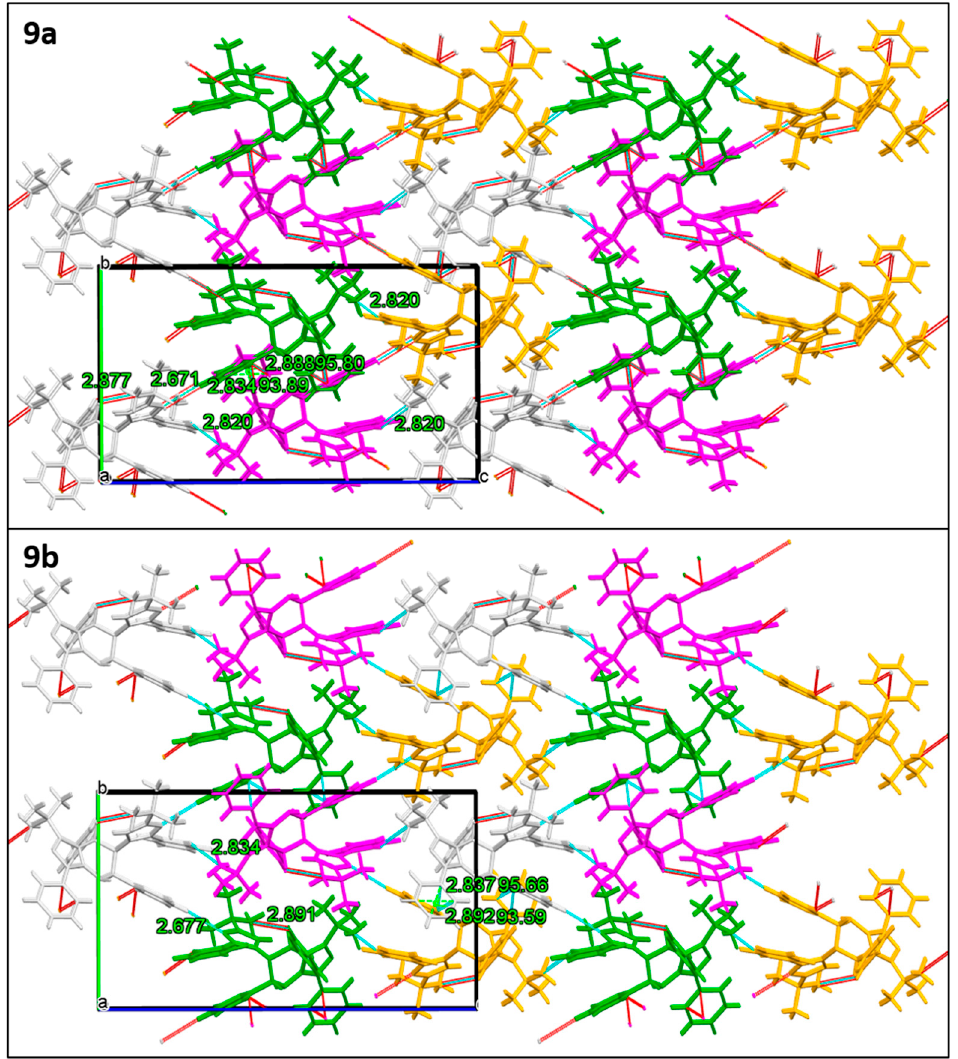
Figure 9. Crystal packing (2.0 × 2.0 × 2.0 supercell) comparison between the two isostructural polymorphs 9a and 9b seen along the bc face and highlighting featured close intermolecular contacts. Molecular units ( Z = 4, Z ′ = 1) are colored based on different symmetry operations. Distances in Angstroms (Å) and angles in grades (°).